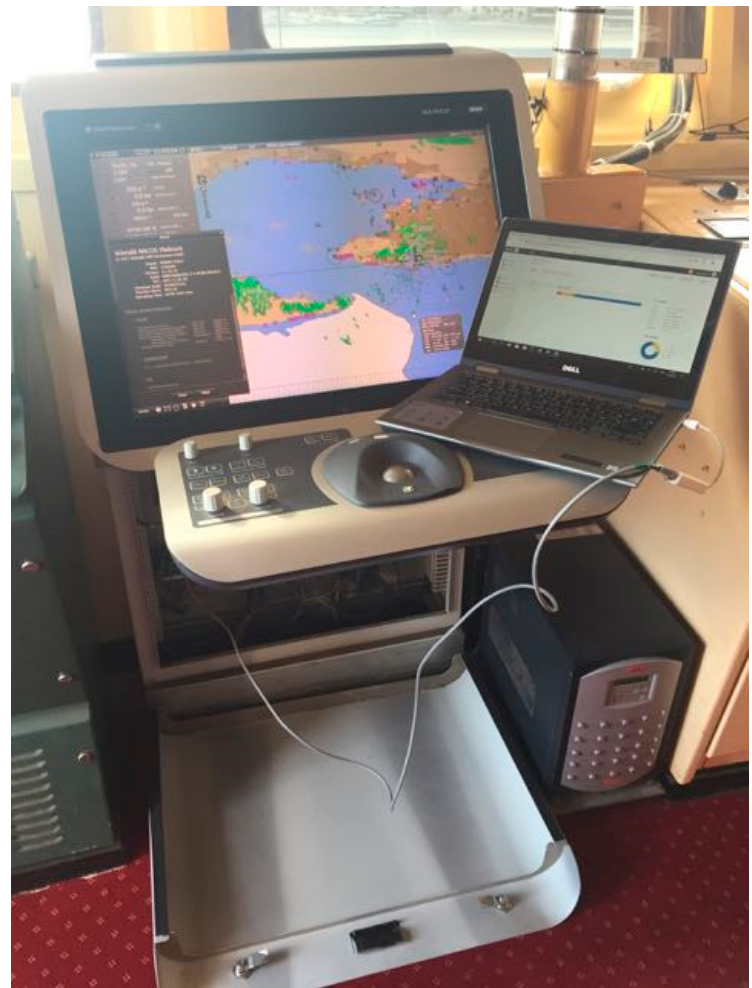
Figure 3. Testing setup for the INS cyber-vulnerability scanning.